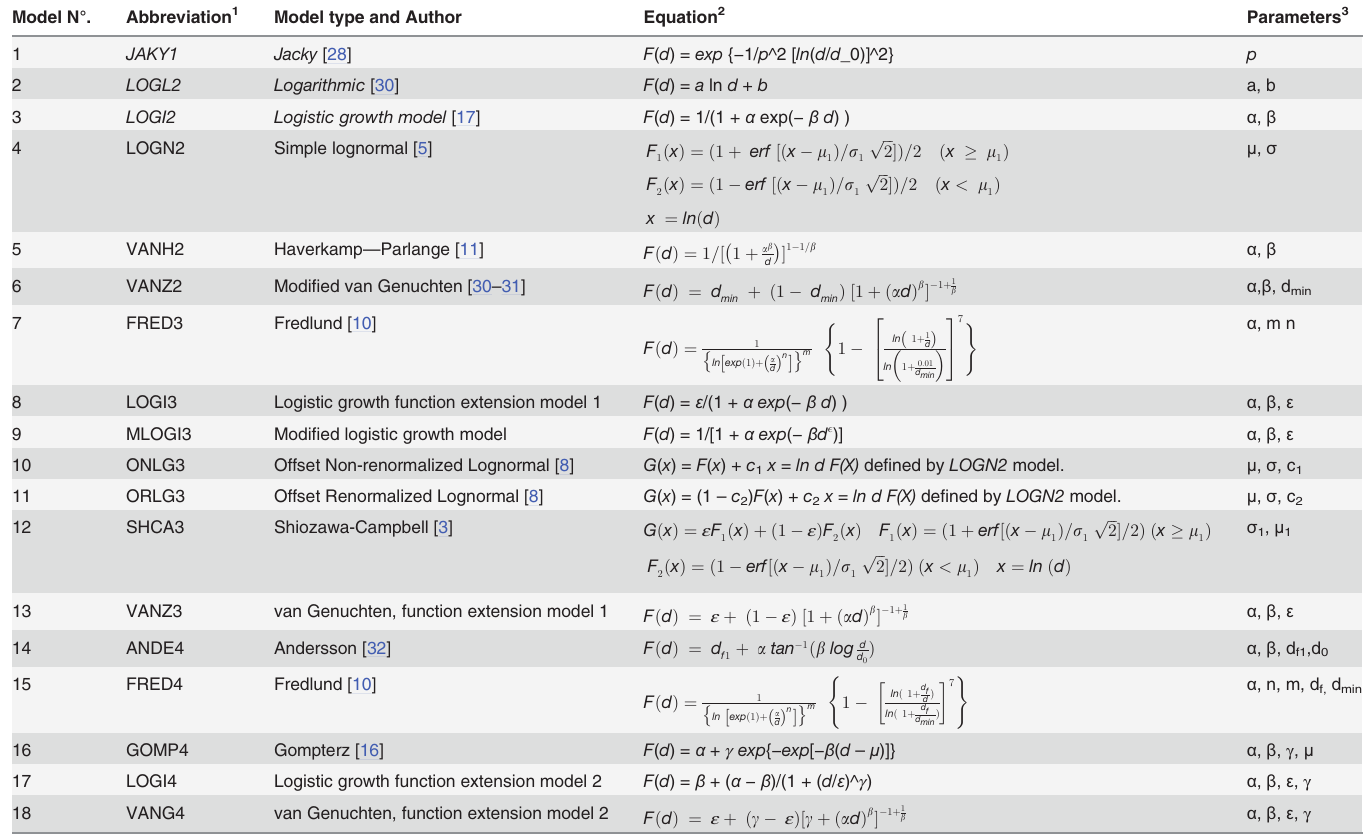
Table 2. Particle size distribution (PSD) functions used in the study. Model